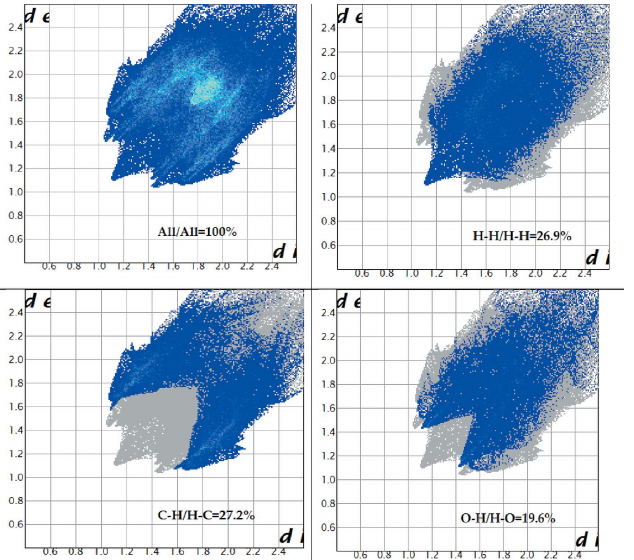
Figure 5 Two-dimensional fingerprint plots for the title compound.